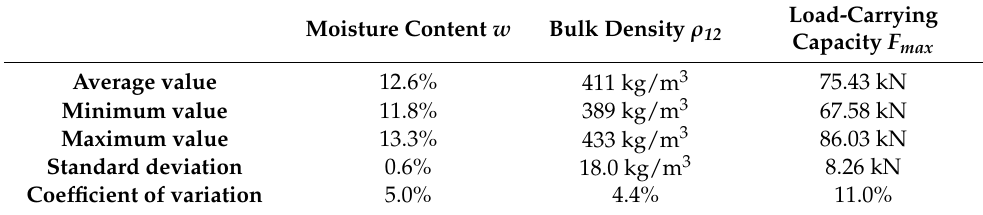
Table 6. Results of the experimental testing of H2 specimens.